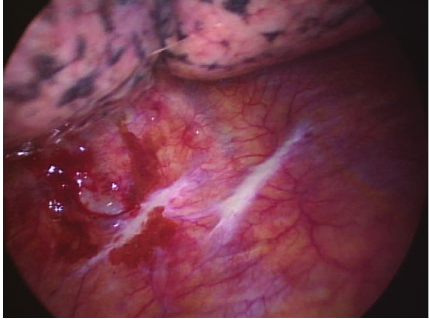
Figure 3: View of left thoracic cavity on medical thoracoscopy demonstrating tumor implants on the parietal pleural surface.